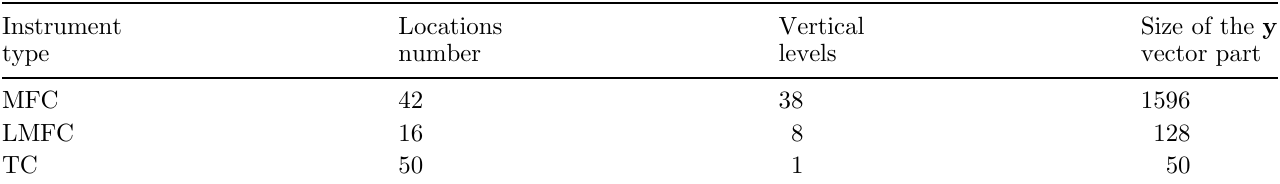
Table 1. Main characteristics of the instruments used for data assimilation. These characteristics remain the same, either in mono-instrumented cases or in multi-instrumented ones.